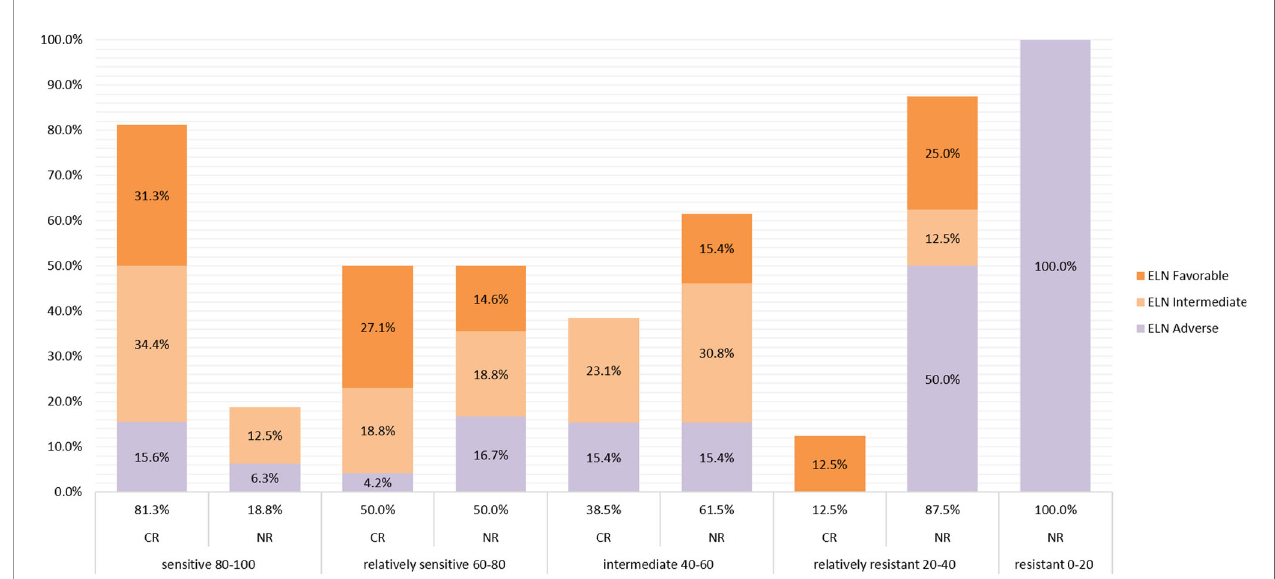
FIGURE 2 | Remission rate of each sensitive group. Patients were divided into 5 groups according to the drug sensitivity results of the actual clinical induction regimen, with 32, 48, 13, 8, and 3 patients from sensitive to resistant, respectively. The clinical CR correlates with the predicted responses, which decreased from sensitive to resistant, to 81.3%, 51.0%, 38.5%, 14.3%, and 0%, respectively. The ELN 2017 classi fi cations of CR patients and non-CR patients in different sensitivity groups are also displayed in different colors in the histogram.